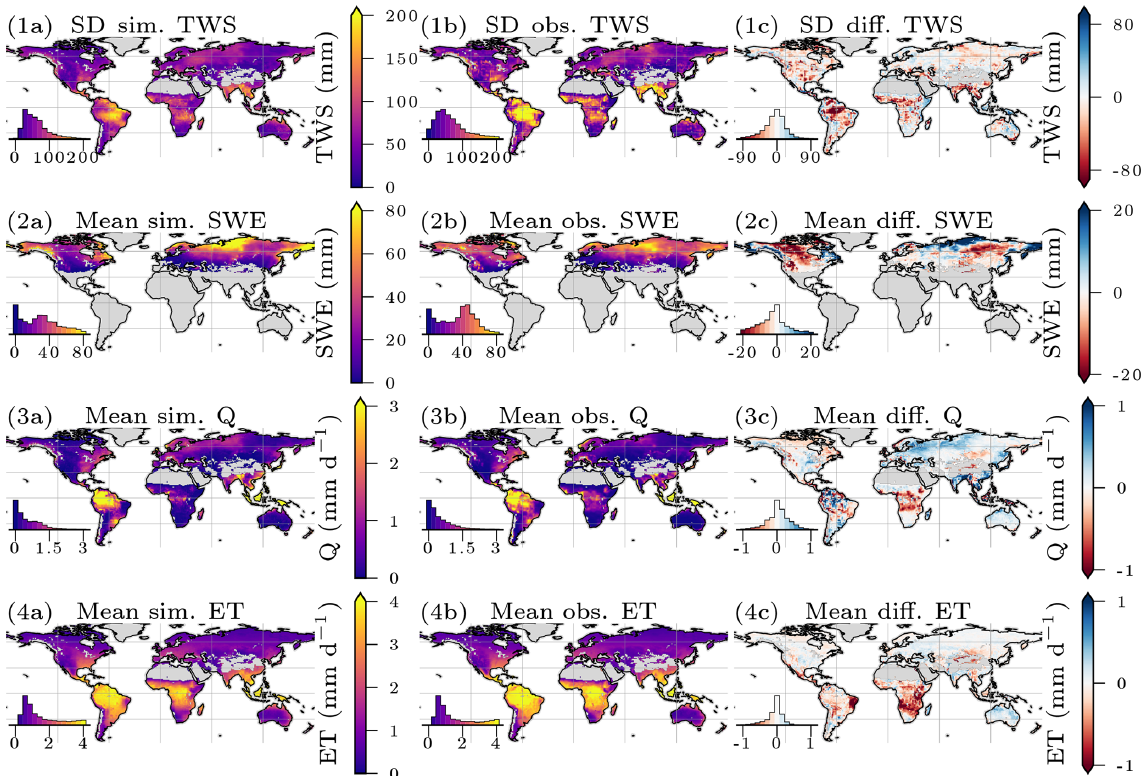
Figure A2. Mean (a) simulated, (b) observed, and (c) the difference of simulated minus observed (positive means simulated is larger) terrestrial water storage ( TWS; 1a–c) , snow water equivalent ( SWE; 2a–c) , total runoff ( Q; 3a–c) , and evapotranspiration ( ET; 4a–c) . Note that, for the TWS, the standard deviation is shown as the values represent variations around the mean. The inset histograms represent the map value distributions, and the mean for the test period (2009 to 2014) is